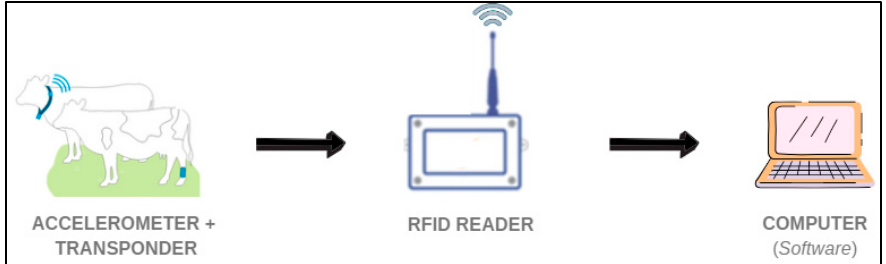
Figure 3. Basic accelerometer system with radiofrequency identification (RFID). Own